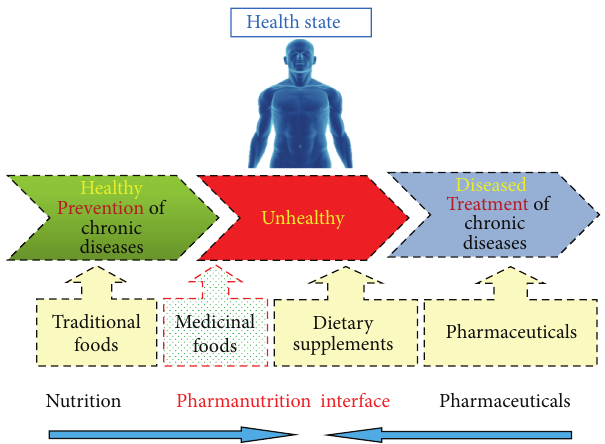
Figure 1: Pharmanutrition